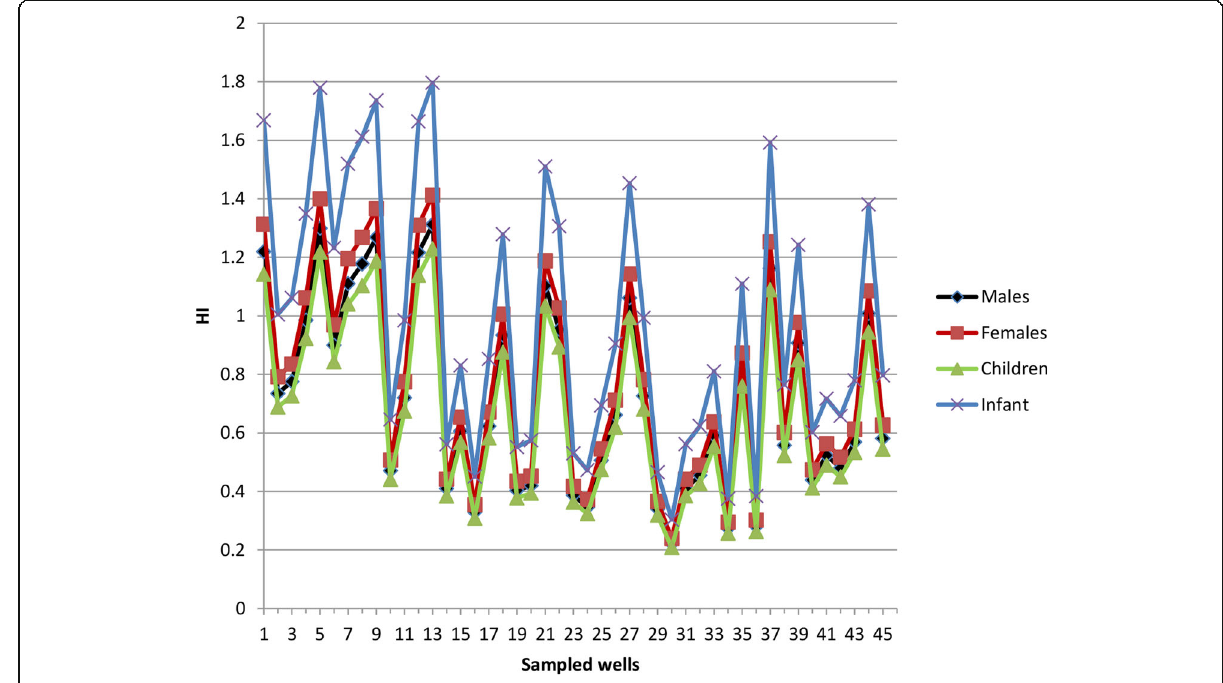
Fig. 4 Average HI values from in the studied groundwater